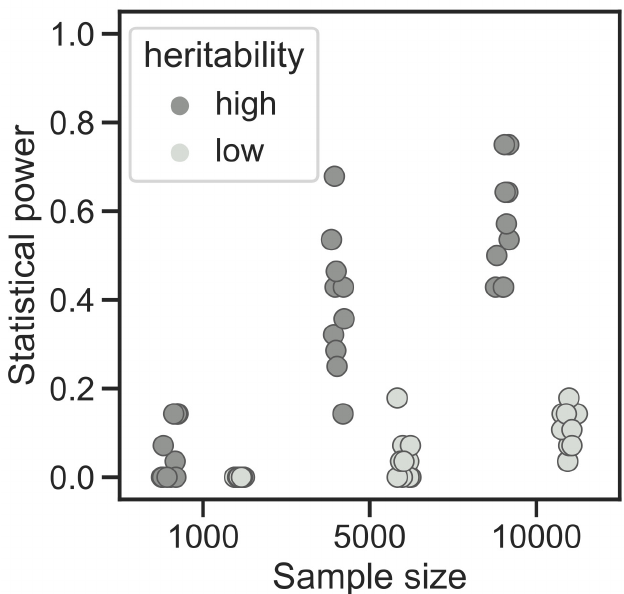
Fig 4. Power simulations. The proportion of causal variants passing the significance threshold is reported for each sample size and heritability for the simulated phenotypes.